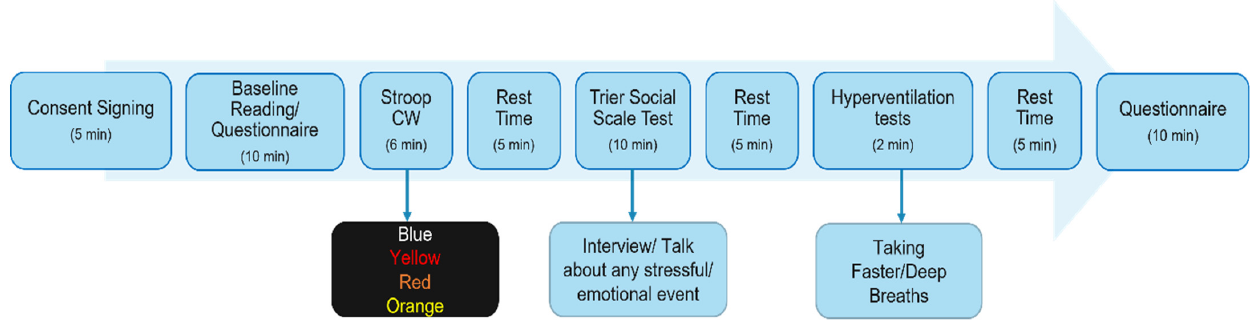
Figure 1. Study Protocol of the stress ‐ monitoring study including 3 stress ‐ inducing tasks/sessions, 2 self ‐ reporting questionnaire sessions and in ‐ between rest sessions.